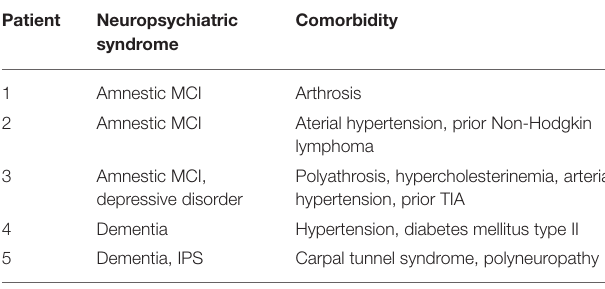
TABLE 2 | Clinical characterization of neuropsychiatric syndromes and comorbidities in patients with glycine receptor